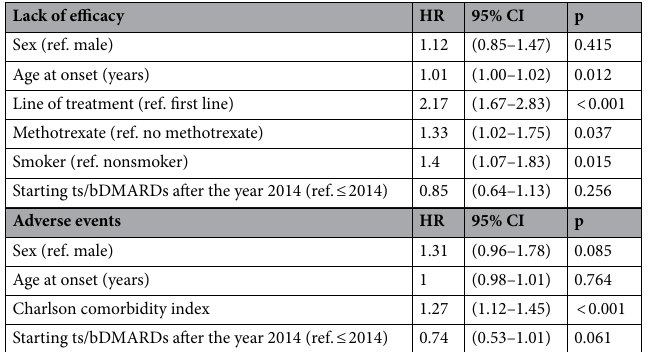
Charlson comorbidity index 1.27 (1.12–1.45) < 0.001 Starting ts/bDMARDs after the year 2014 (ref. ≤ 2014) 0.74 (0.53–1.01) Table 4. Factors associated with treatment discontinuation. Multivariate regression model in the group of patients with ankylosing spondylitis. HR hazard ratio; CI confidence interval.